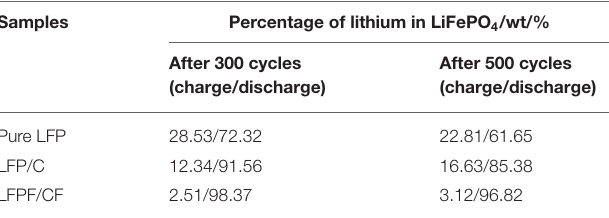
TABLE 1 | The ICP analysis of pure LFP, LFP/C, and LFPF/CF composite after cycling, respectively (fully charged/discharge). Samples Percentage of lithium in LiFePO 4 /wt/% After 300 cycles After 500 cycles (charge/discharge) (charge/discharge) Pure LFP